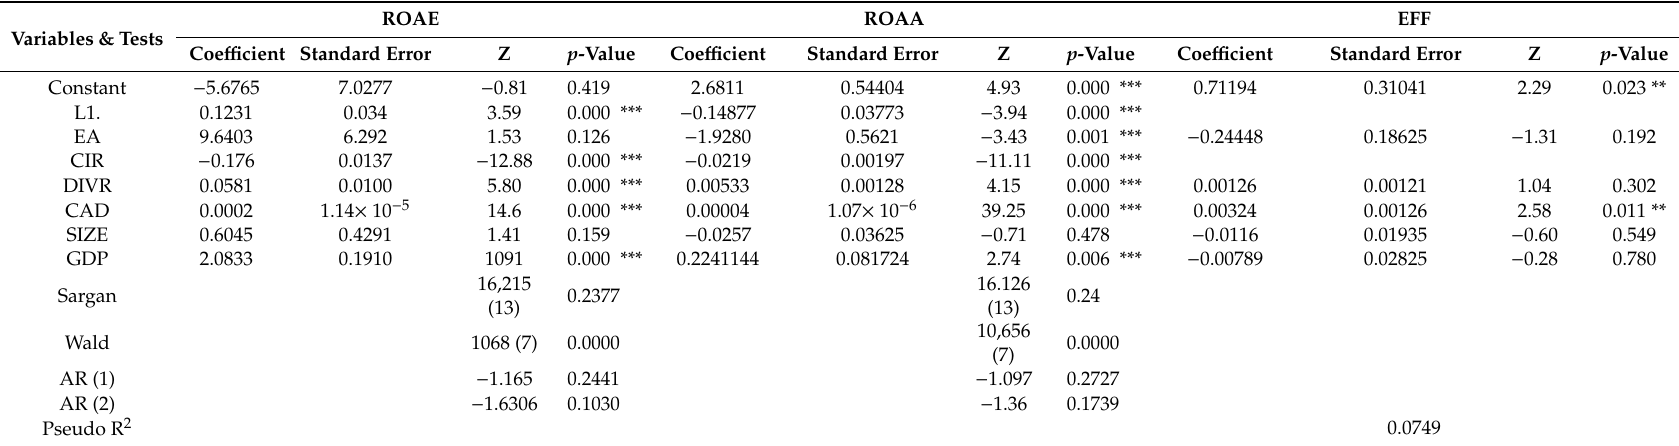
Table 4. Results of the Models formulated in Equations (1), (2) and (4): Estimation for the Banks in the Iberian Peninsula Sample considering a linear relationship between bank size and